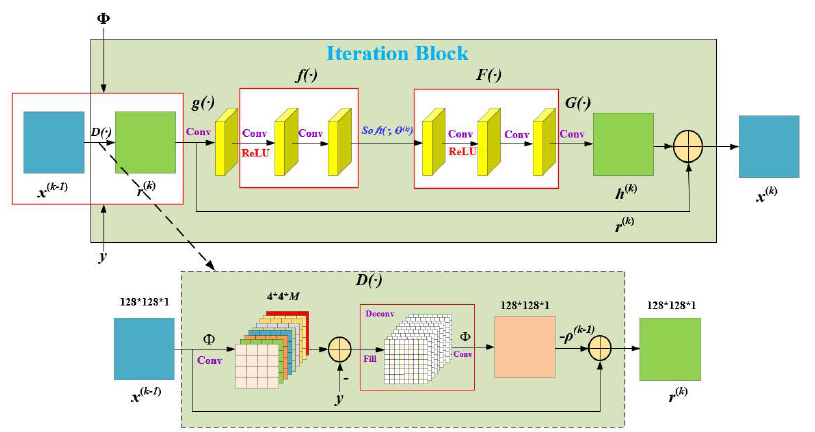
Figure 5. Structure diagram of the iteration block based on large convolutional layer sampling. D (·) is a specially designed network structure that enables the measurement matrix to be input into the iteration blocks as a learnable parameter.